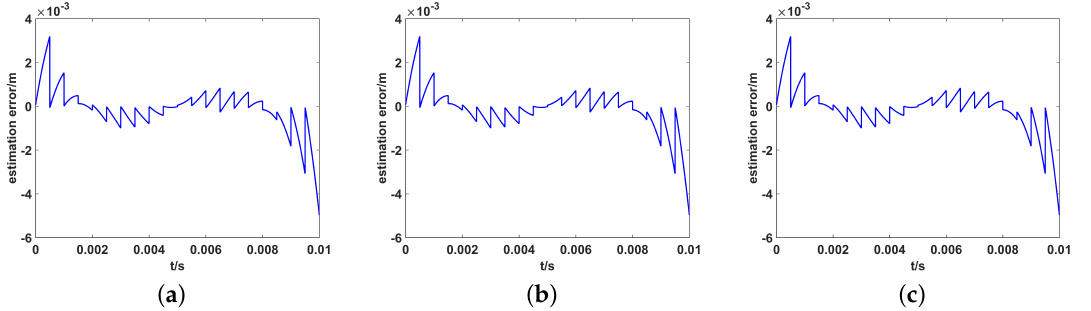
Figure 14. The estimation error of antenna position in three-dimensional translations. ( a ) Only along the X t ; ( b ) Only along the Y t ; ( c ) Only along the Z t